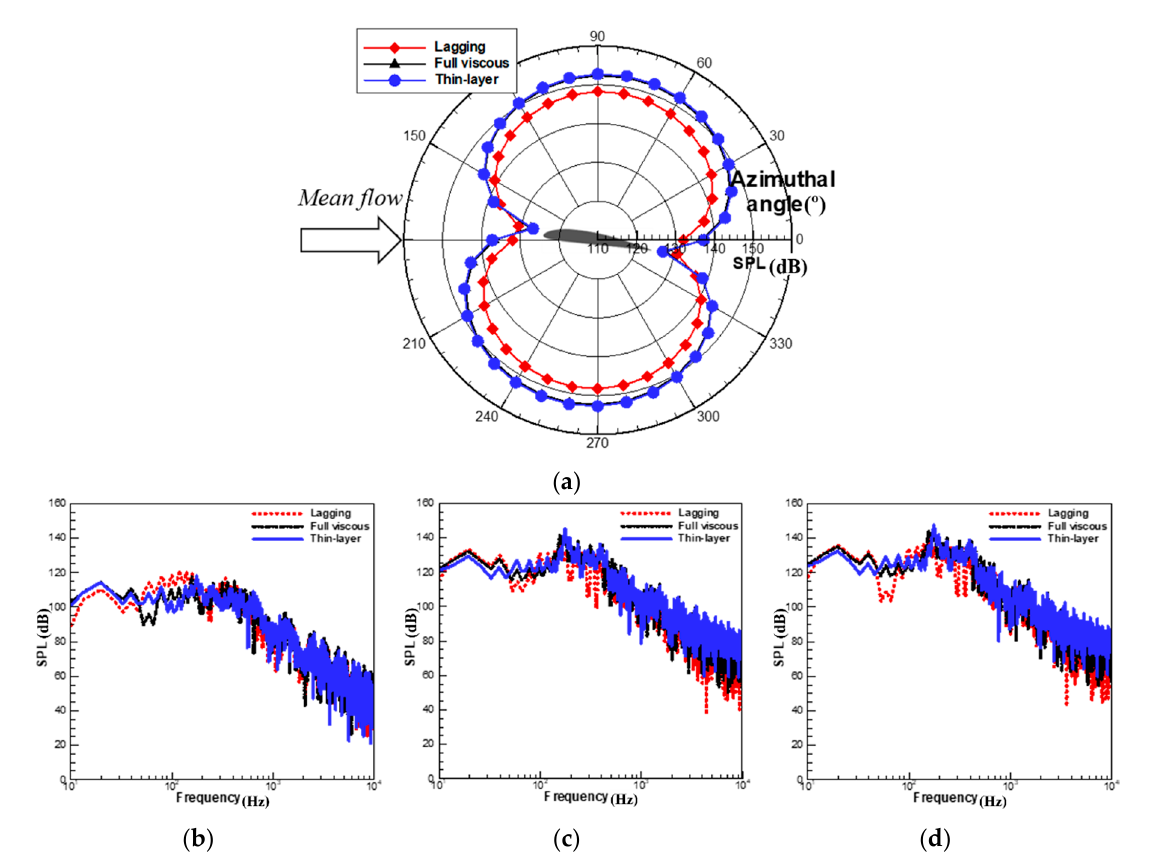
Figure 19. Predicted hydro-acoustic pressure due to monopole source: ( a ) directivity, spectrum at three azimuth angles of ( b ) 350°; ( c ) 40°; and ( d ) 80°.